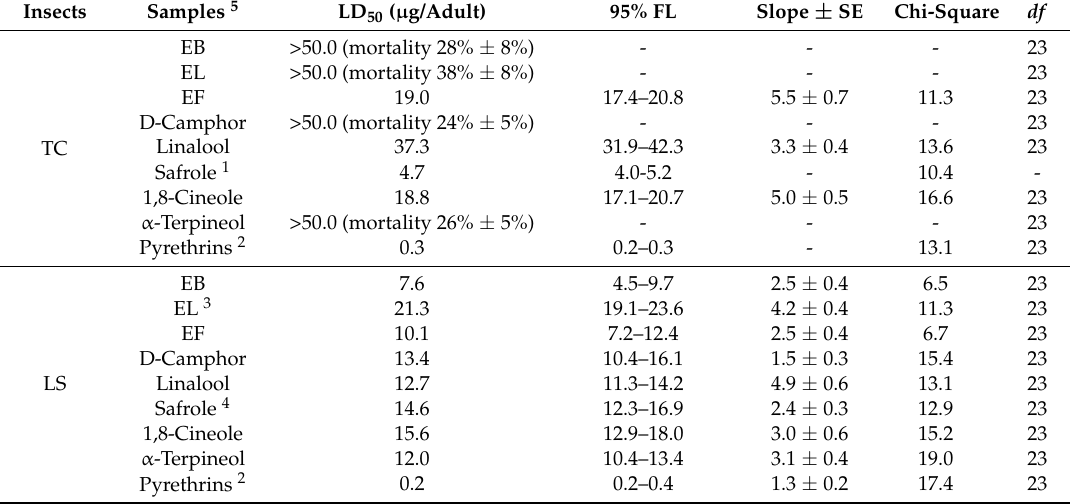
Table 3. Contact toxicity of essential oils and individual compounds against T . castaneum (TC) and L. serricorne (LS) adults at 24